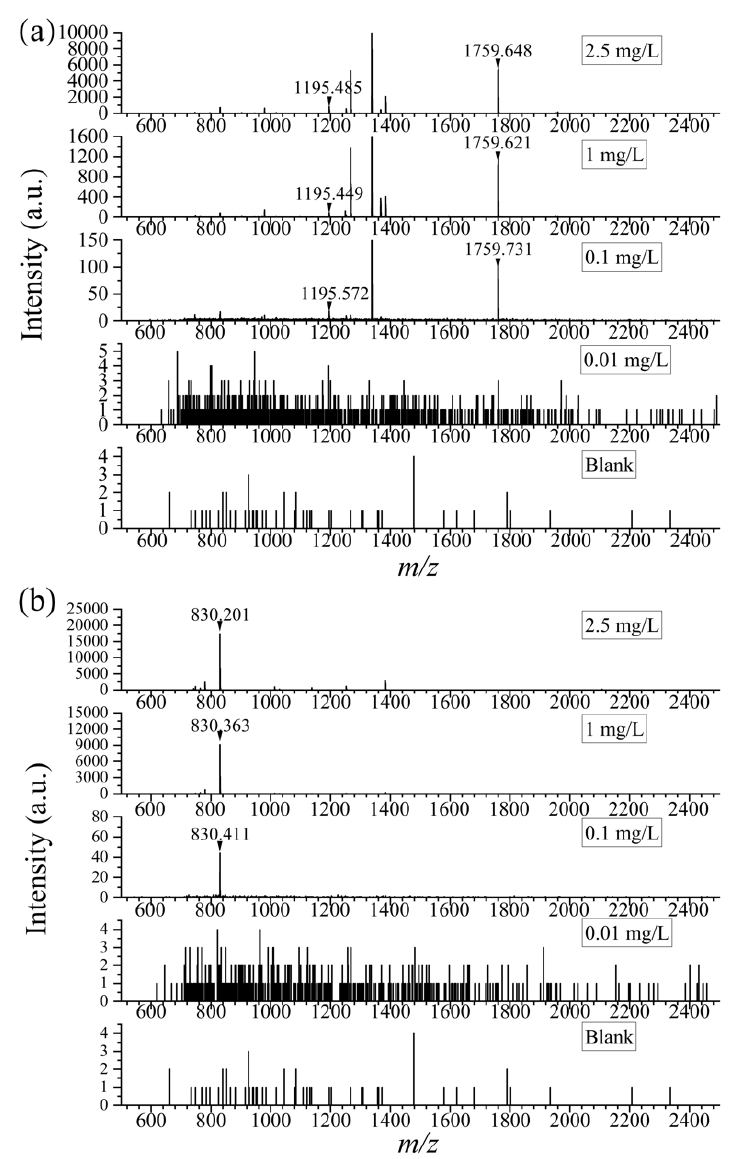
Figure 2. The mass spectra of specific peptides in α -casein ( a ) and β -casein ( b ) at different concentra- tions (0, 0.01 mg/L, 0.1 mg/L, 1 mg/L, 2.5